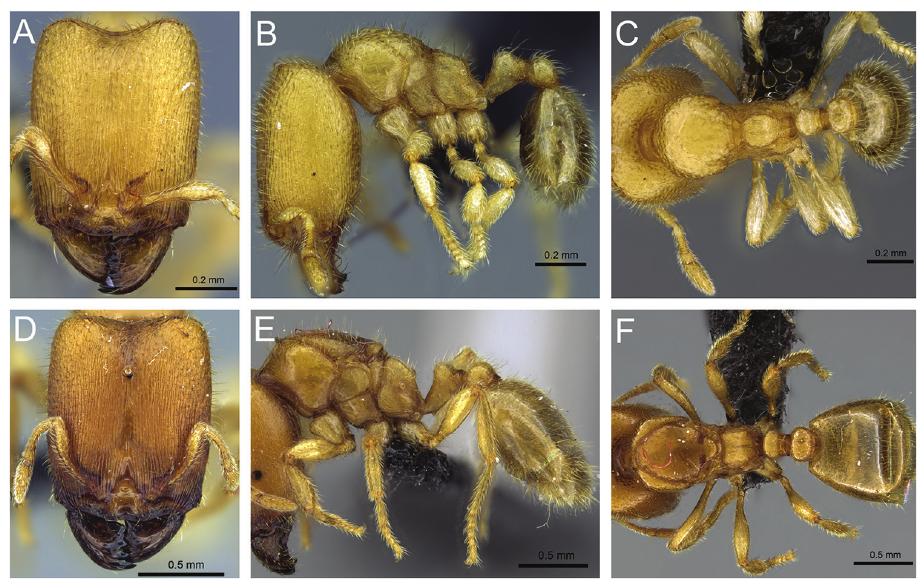
Figure 58. Intermediates of Carebara placida . Major workers, CASENT0845056: A head in full-face view B body in profile view C body in dorsal view. CASENT0070818: D head in full-face view E body in profile view F body in dorsal